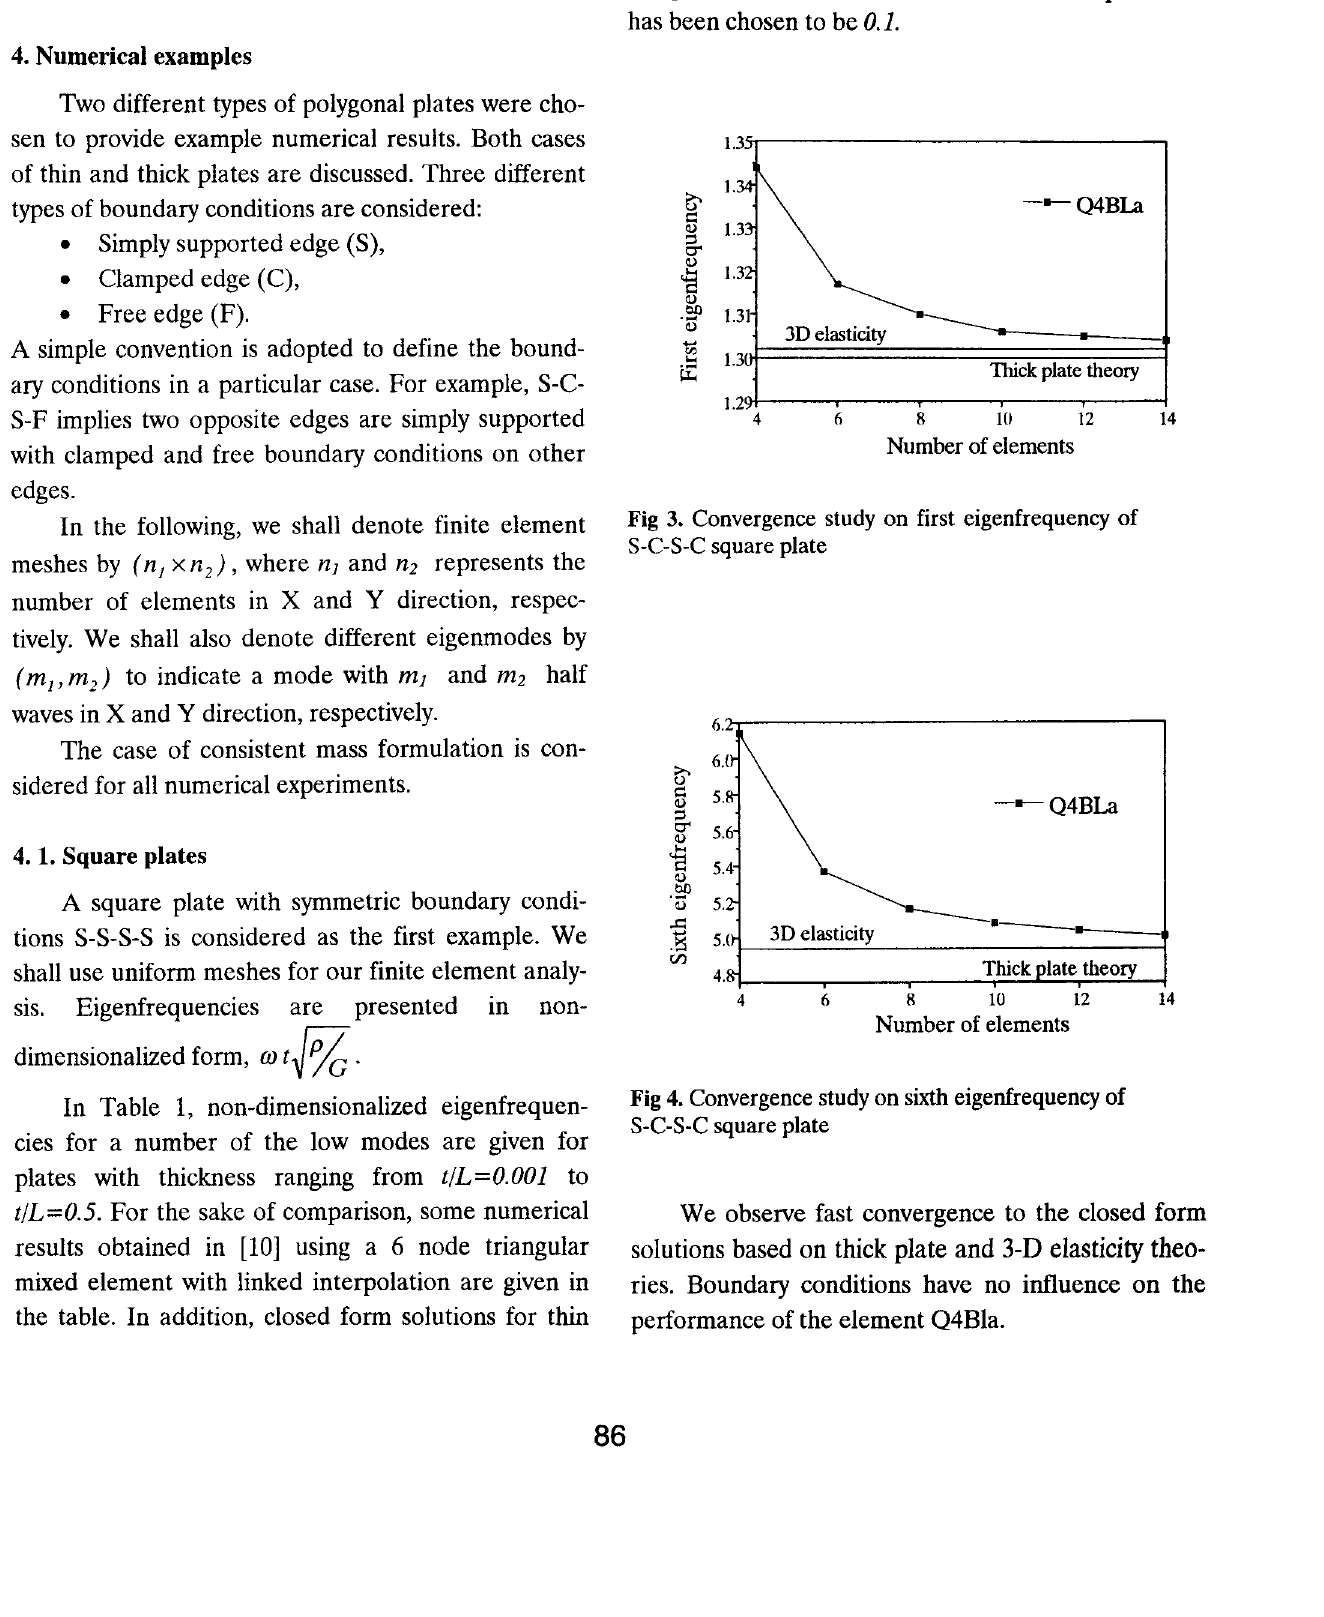
Fig 4. Convergence study on sixth eigenfrequency of S-C-S-C square